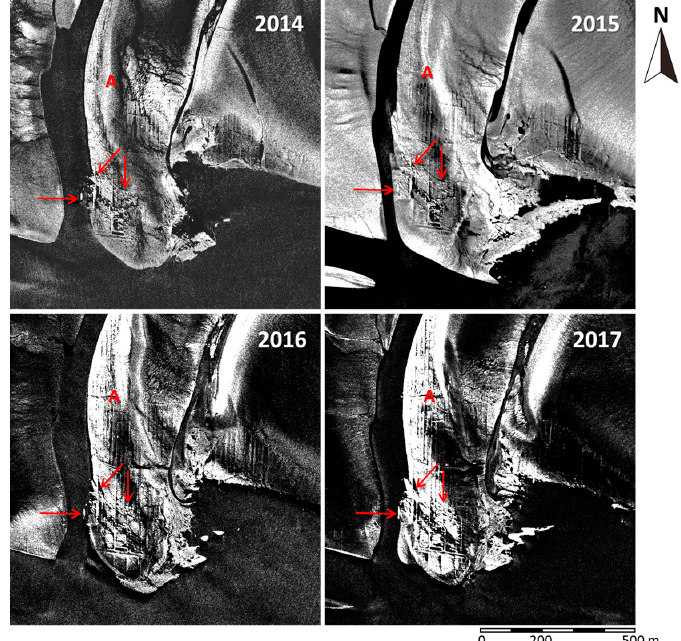
Figure 8. Subsections (1000 m × 1000 m) of four TerraSAR-X/TanDEM-X staring spotlight scenes acquired on ( upper left ) 19 November 2014, ( upper right ) 20 January 2015, ( lower left ) 18 July 2016, and ( lower right ) 22 June 2017. The linear structures are cultural traces. The letter (A) is introduced for convenience (see text), the arrows are inserted for intercomparison with Figure 7. © DLR 2014, 2015.